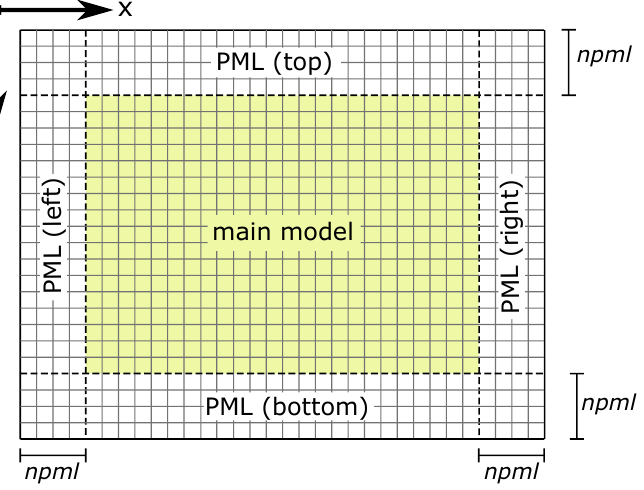
Figure 4. Perfectly matched layers in finite difference grid ( npml = Number of grids in perfectly matched